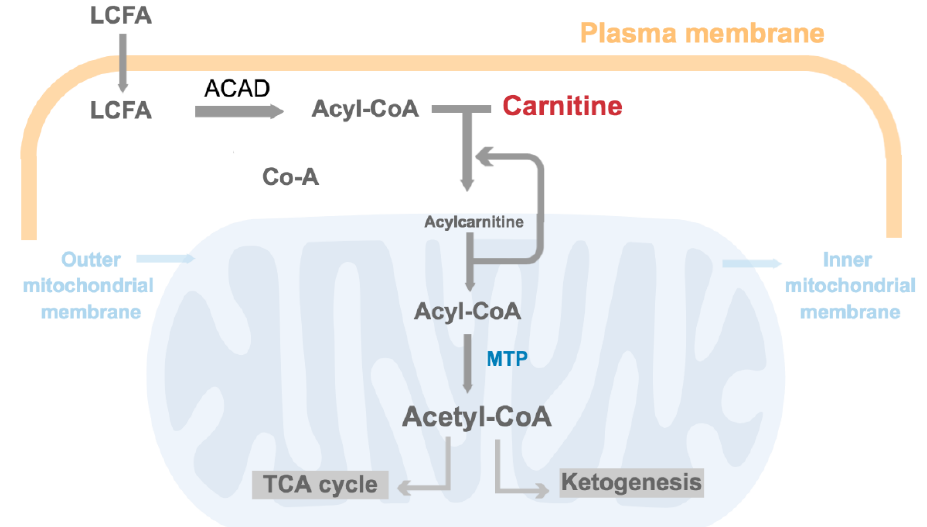
Figure 2. Schematic diagram of mitochondrial fatty acid entry and beta oxidation. Long chain fatty acid (LCFA) is activated by bonding with CoA upon cell entry. Acyl-CoA dehydrogenase (ACAD) catalyzes this first reaction. This molecule, now an acyl-CoA, is shuttled through the mitochondrial membrane by forming an ester bond with carnitine, thus generating acylcarnitine. Once inside the mitochondria, acylcarnitine is broken down to produce free carnitine, which can be recycled to shuttle in further fatty acids in the mitochondria. The long chain acyl-CoA generated is then oxidised to produce acetyl-CoA, a process catalysed by mitochondrial trifunctional protein (MTP). Acetyl-CoA can be utilised in the tricarboxylic acid cycle (TCA) cycle or participate in ketogenesis.